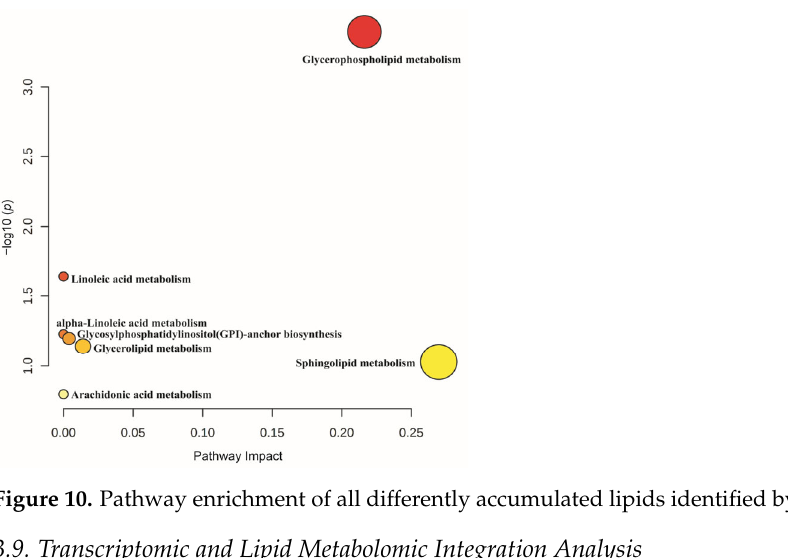
Figure 12. Map of the regulatory mechanisms of candidate genes regulating fat deposition. Fatty acid composition is a complex quantitative trait that determined the hardness and oiliness of adipose tissue and then affected the sensory quality and nutritional value of meat [43]. In mammalian cells, FAs undergo elongation, desaturation, β ‐ oxidation, and peroxidation to synthesize complex lipids such as TG, phospholipids, and sphingolipids